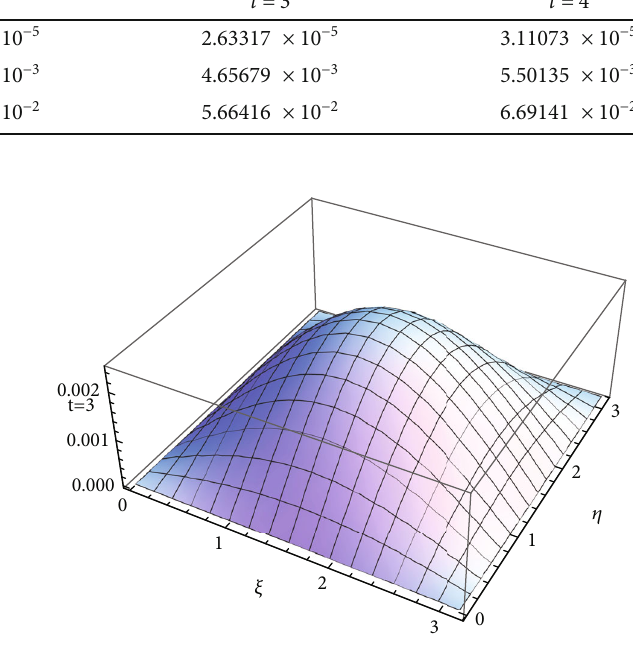
Figure 15: Approximate error for Example 9 at t=3.